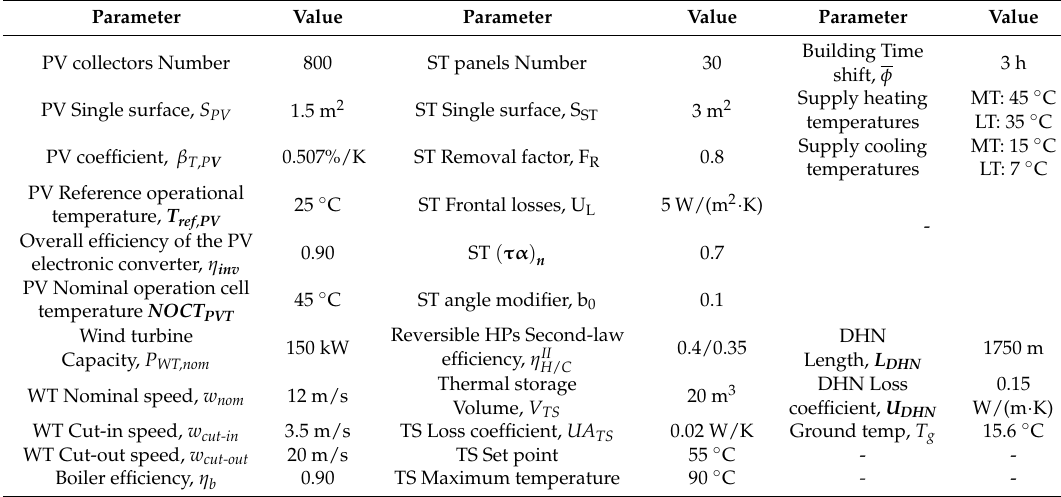
Table 2. Parameters used in the